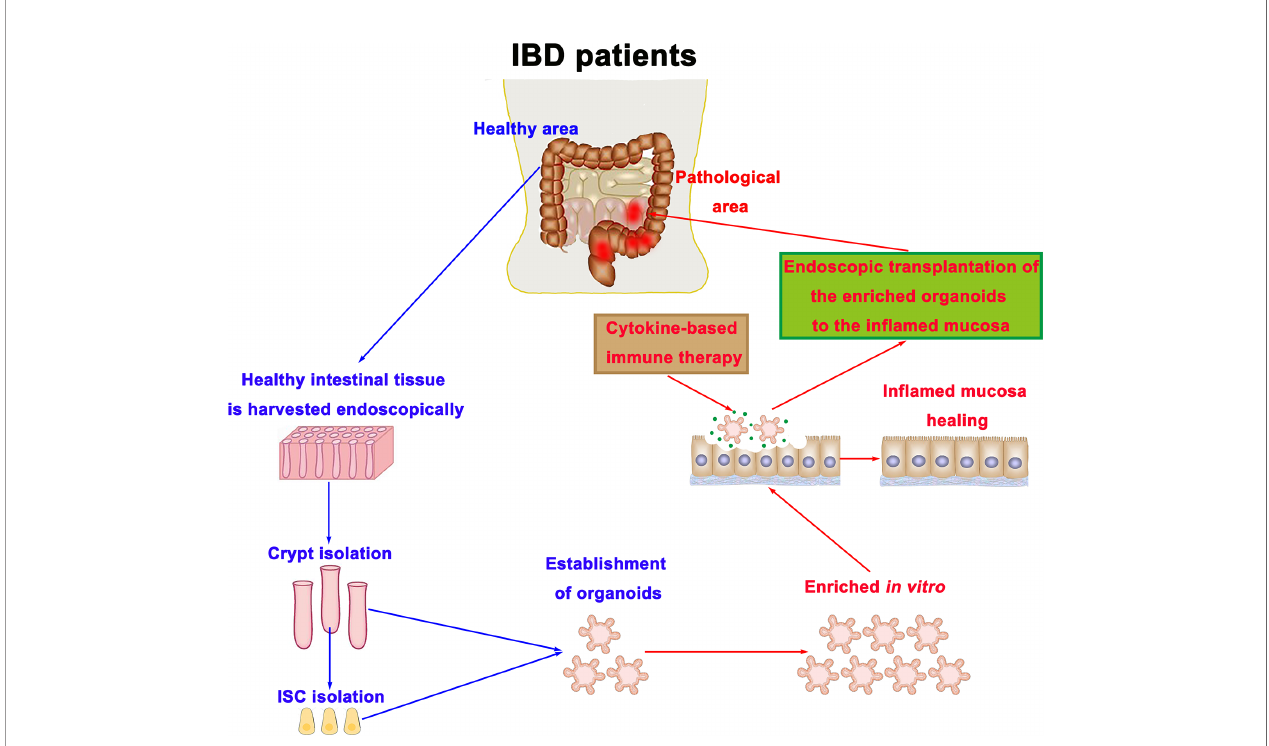
FIGURE 4 | Intestinal stem cell therapy strategy in IBD. Intestinal crypts and ISCs can be harvested endoscopically from healthy intestinal mucosa in IBD patients, and then expanded in vitro by the established organoid culture method. After growing them to a desired number of cells, they can be transplanted onto the target site through an endoscopic delivery method. ISC, intestinal stem cell; IBD, in fl ammatory bowel